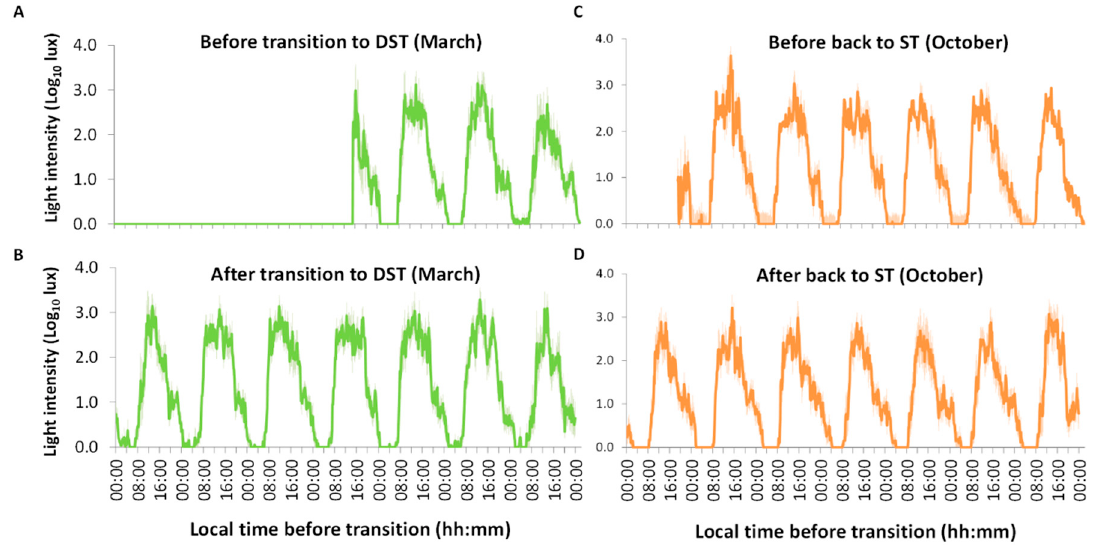
Figure 2. Average ( n = 8) light exposure in log lux units (± SEM) for all participants ( n = 8) before ( A ) and after ( B ) transition to DST, and before ( C ) and after ( D ) transition back to ST.